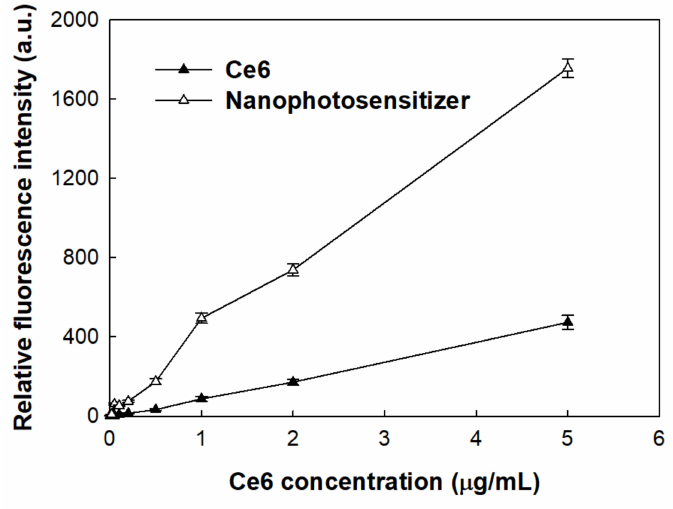
Figure 6. Ce6 uptake by HeLa cells. Cells were treated with Ce6 or FaPEGbCDseseCe6 nanophotosen- sitizers for 2 h and then measured fluorescence intensity as a Ce6 uptake ratio (Excitation wavelength of 407 nm, emission wavelength of 664 nm).